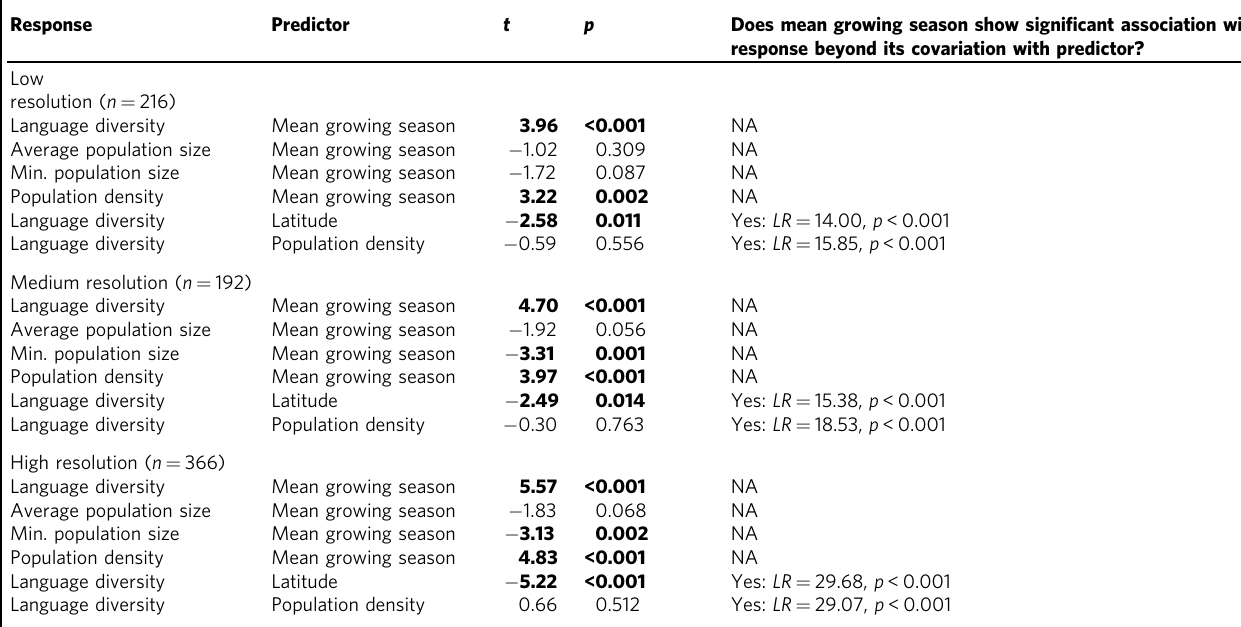
Table 2 Predictions of the ecological risk hypothesis